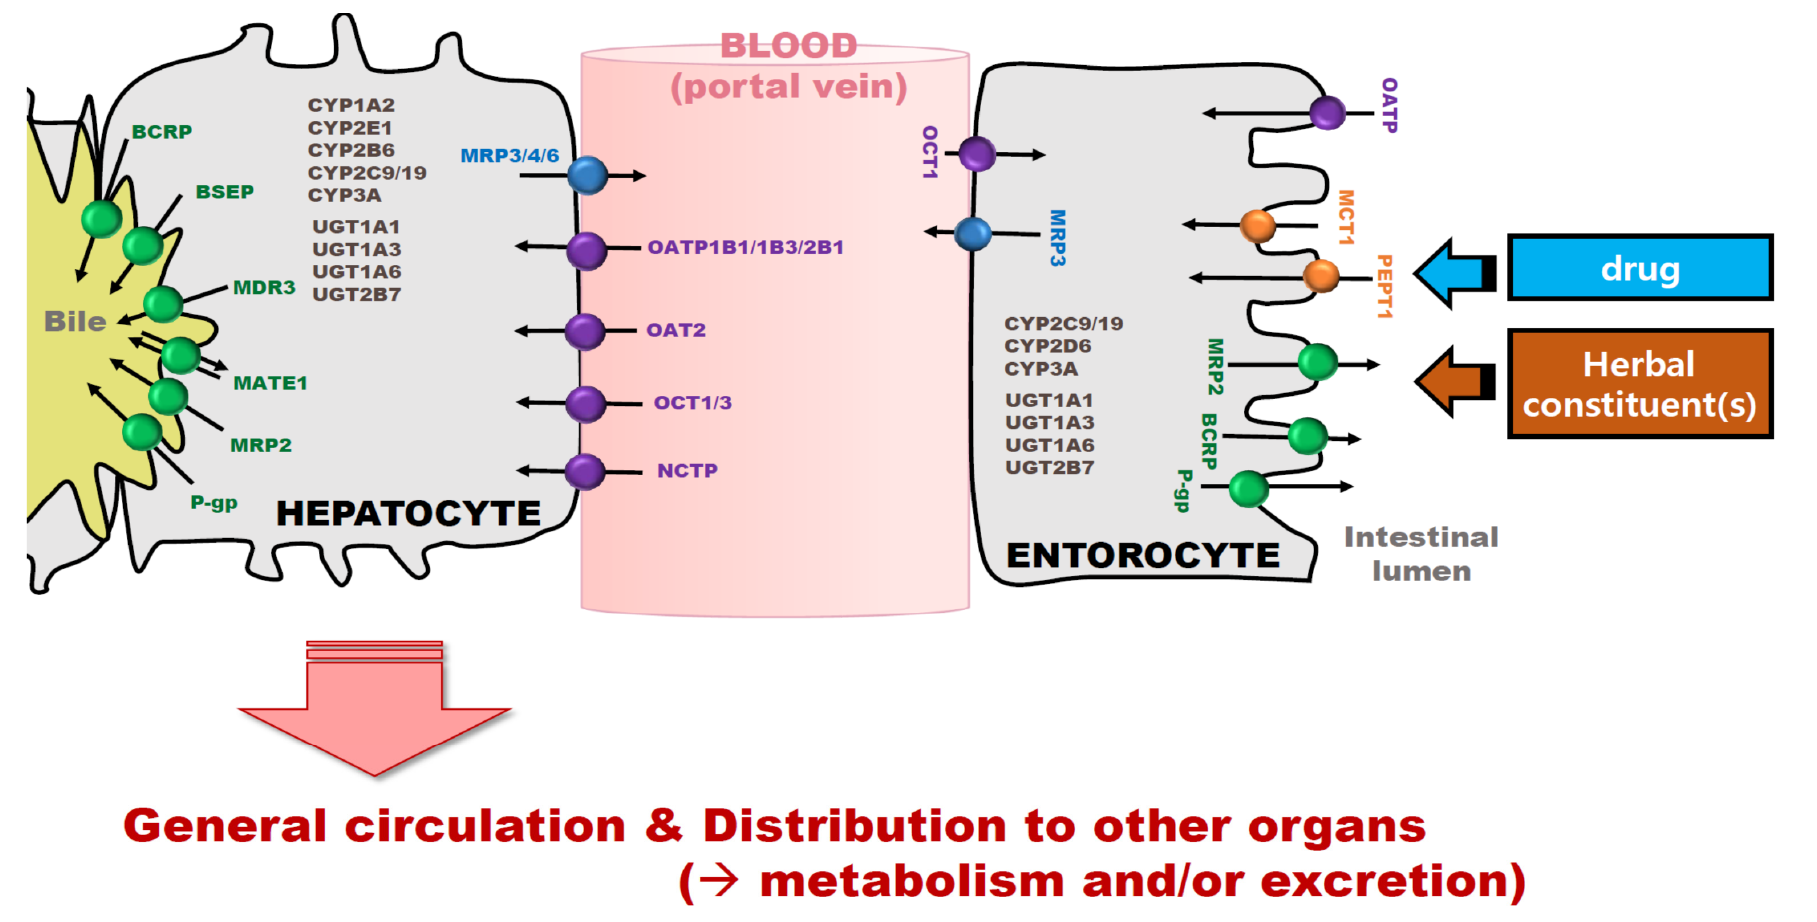
Figure 1. Transporter- and metabolic enzyme-mediated disposition patterns of drug and herbal products. 2